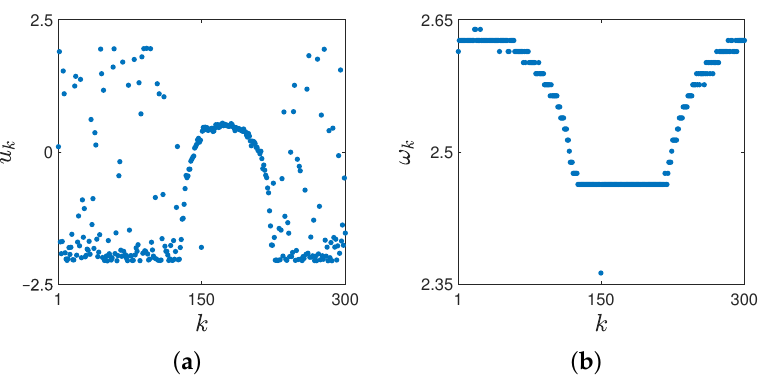
Figure 4. Pruning one neuron is not effective enough to control the position of chimera states. ( a ) Snapshot of u k for t = 1000, ( b ) mean phase velocities ω k .